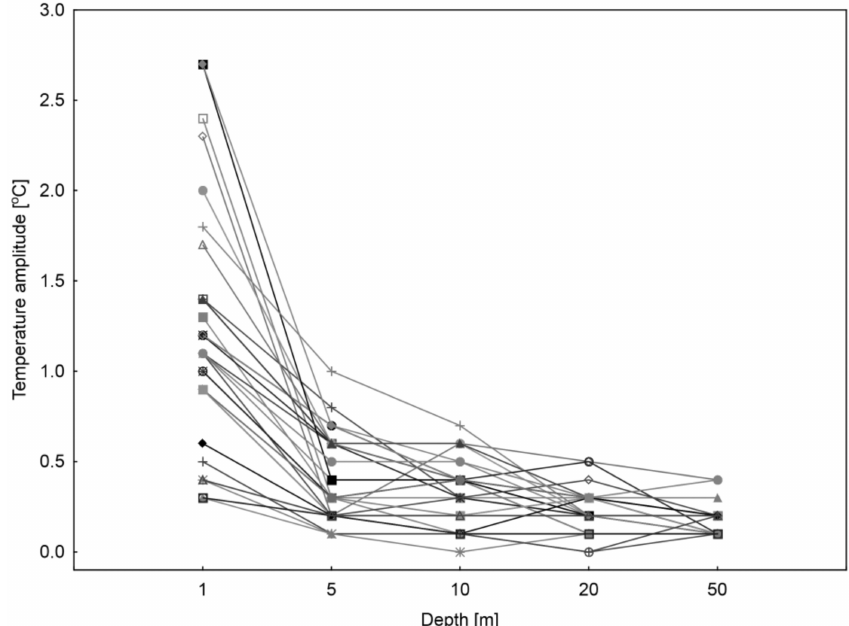
Figure 6. Correlation between water temperature amplitude and depth in Lake Morskie Oko. Temperature profile Type 1. The dates for each line are described in detail in the text above.